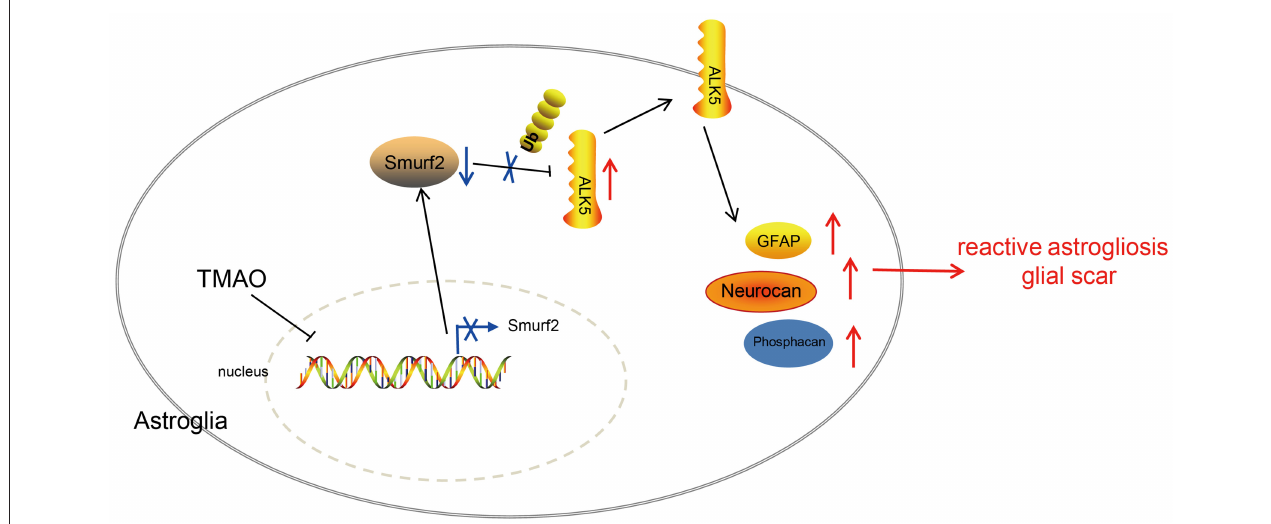
FIGURE 7 | Graphic presentation of molecular mechanism underlying TMAO in ischemic stroke. TMAO promoted the expression of ALK5 by downregulating Smurf2, thereby inhibiting the recovery of neurological function in ischemic stroke and promoting reactive astrocyte proliferation and glial scar